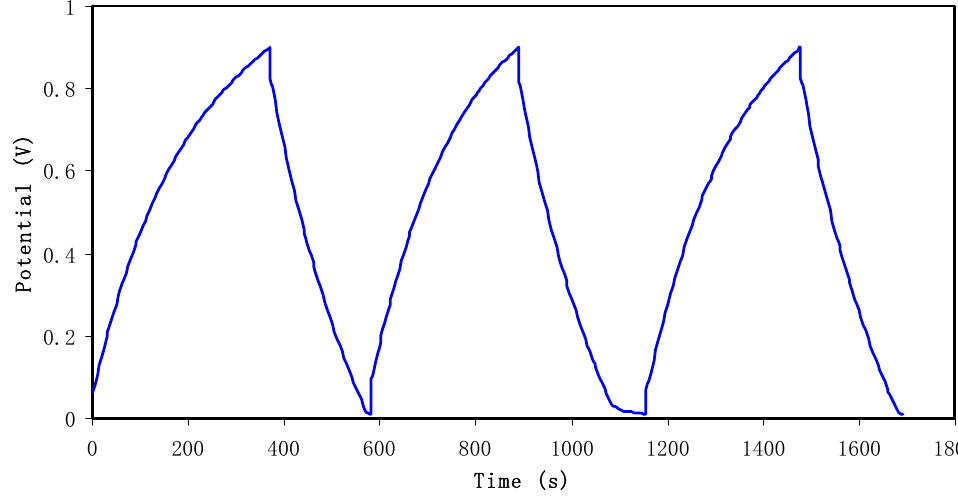
Figure 6. Charge–discharge profiles of the fabricated EDLC at selected cycles.